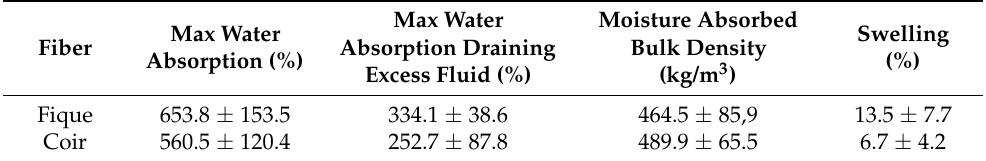
Figure 8. Microstructure after immersion test of ( a ) Coir panel, ( b ) Fique panel.